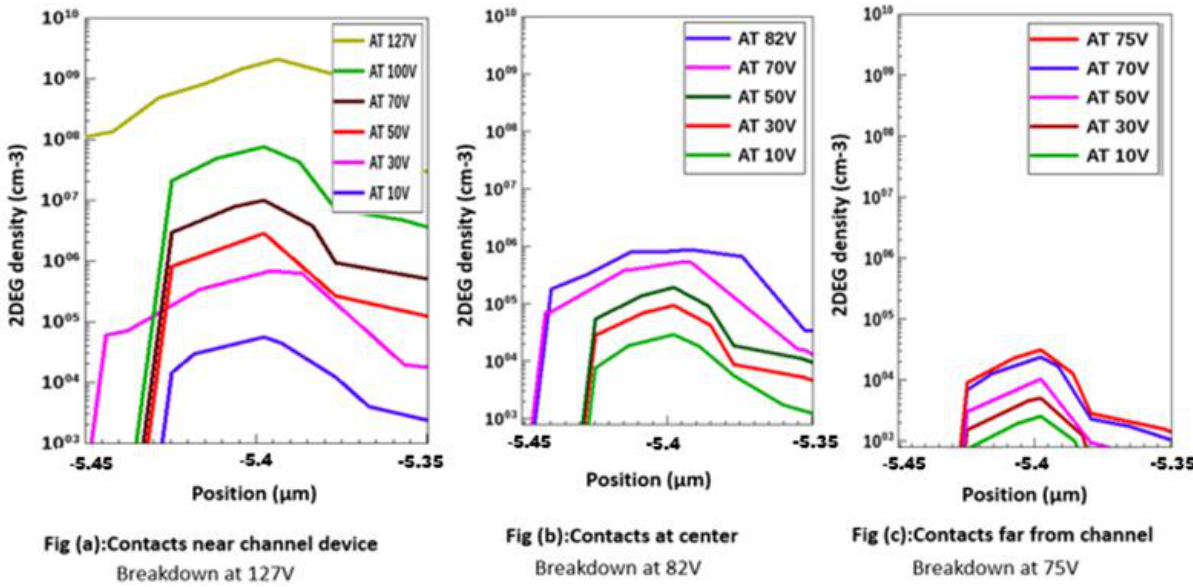
Figure 5. 2DEG density vs. applied voltages with different metal contact positions.